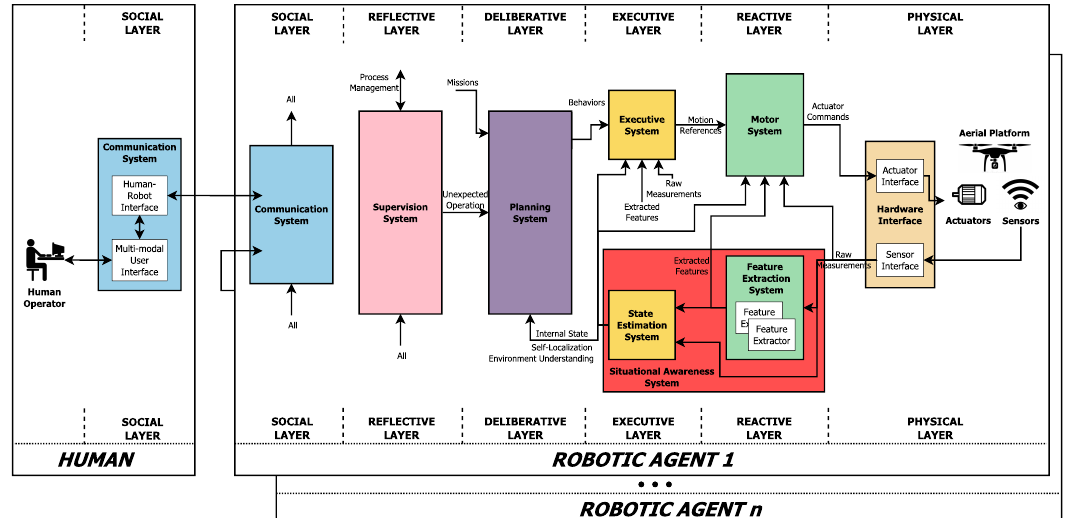
Figure 1. Aerostack system architecture [34]. The reader must note the importance of the situational awareness system (colored in